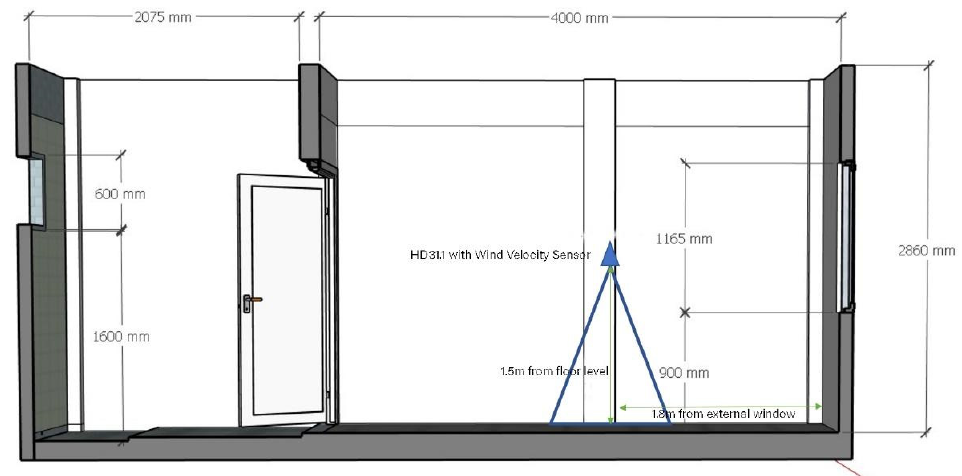
Figure 6. Position of the wind velocity sensor in the case study room (master bedroom in a Level 3 apartment unit).